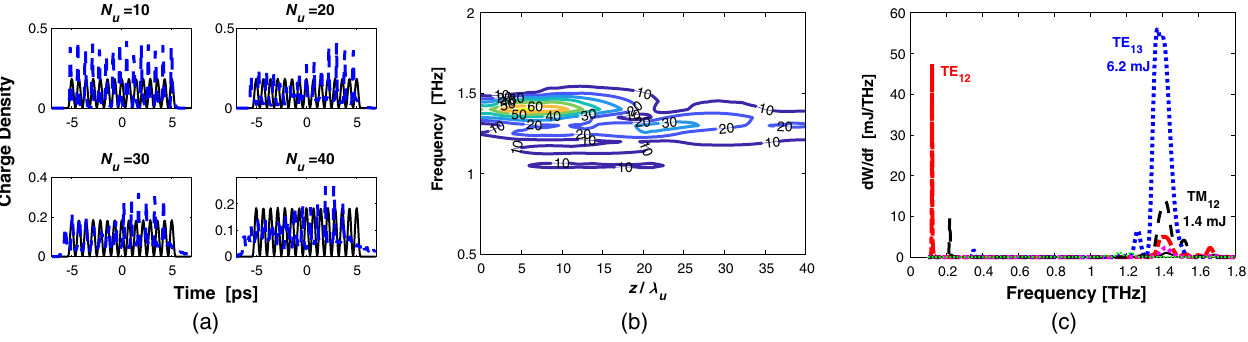
FIG. 9. Bunch with a charge of 7.5 nC and 15 periods of unity modulation at a frequency of 1.4 THz in NMI regime (over-resonance guiding field of 75 kG): (a) charge density after 10 to 40 undulator periods, (b) contours of the bunching factor, and (c) radiation spectrum after 40 undulator periods.